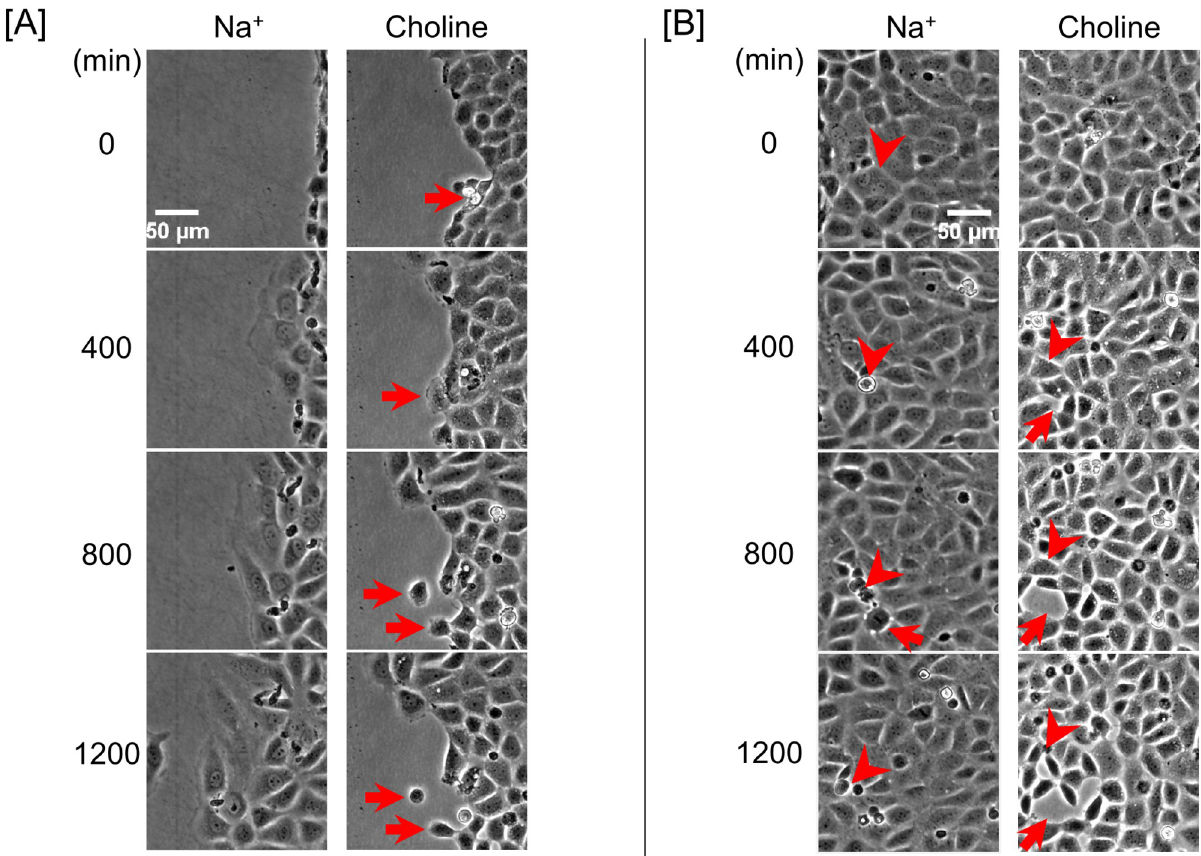
Fig 3. Contribution of extracellular Na + to PAEC protruding lamellipodia, sustaining and reinstating intercellular adhesion, and advancing persistently. (A) Sequential phase-contrast images of a PAEC wound edge at 400-minute intervals in the presence and absence of extracellular Na + . PAECs at the leading edge protruded prominent and stable lamellipodia in Na + -containing media. In choline-containing media, fewer PAECs at the wound edge protruded lamellipodia, and most protruded lamellipodia were relatively smaller. Cells divided at the wound edge gradually formed interendothelial gaps and then detached from the monolayer. The detached individual cells thus lost lamellipodia and cell polarity, and eventually stopped migrating. (B) Sequential phase-contrast images of a confluent PAEC monolayer at 400-minute intervals in the presence and absence of extracellular Na + . In both conditions, transient gaps were both observed during cell divisions (arrowheads). Gaps were generally small and sealed quickly in Na + condition (arrows). However, in choline condition, some sustained gaps were also observed. Some gaps formed even without cell division. The sustained gaps fused with adjacent newly formed gaps leading to gap size increase. Cell division instances are identified with arrowheads. Interendothelial gaps are identified with